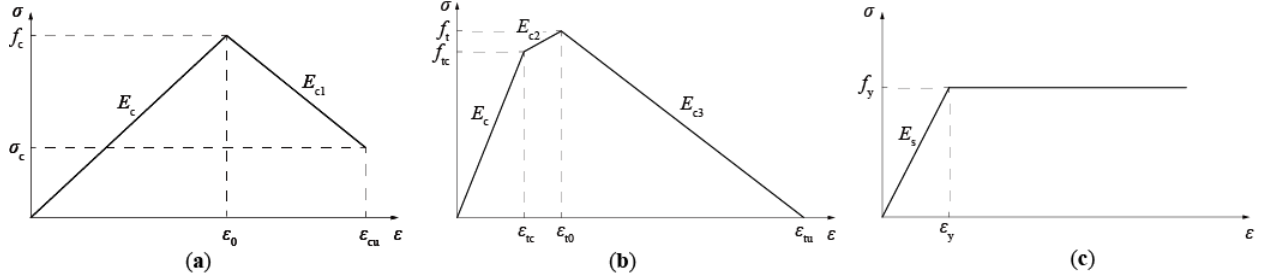
Figure 12. Material models. ( a ) Compression model of UHPC; ( b ) tensile model of UHPC; ( c ) model of steel rebar.